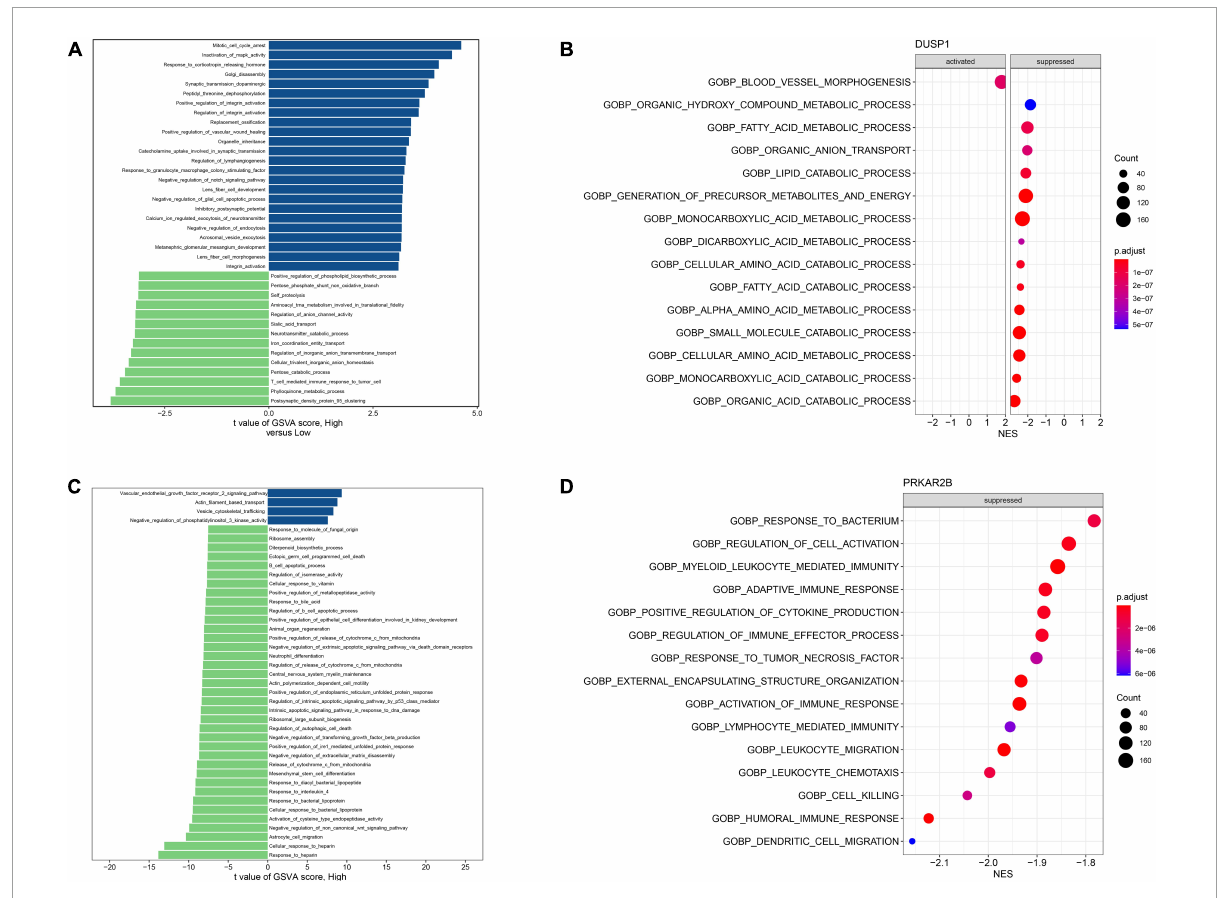
FIGURE7 Exploring the biological processes related to the two candidate diagnostic marker genes. (A) GSVA analysis for the biological processes related to DUSP1. (B) GSEA analysis for the biological processes related to DUSP1. (C) GSVA analysis for the biological processes related to PRKAR2B. (D) GSEA analysis for the biological processes related to